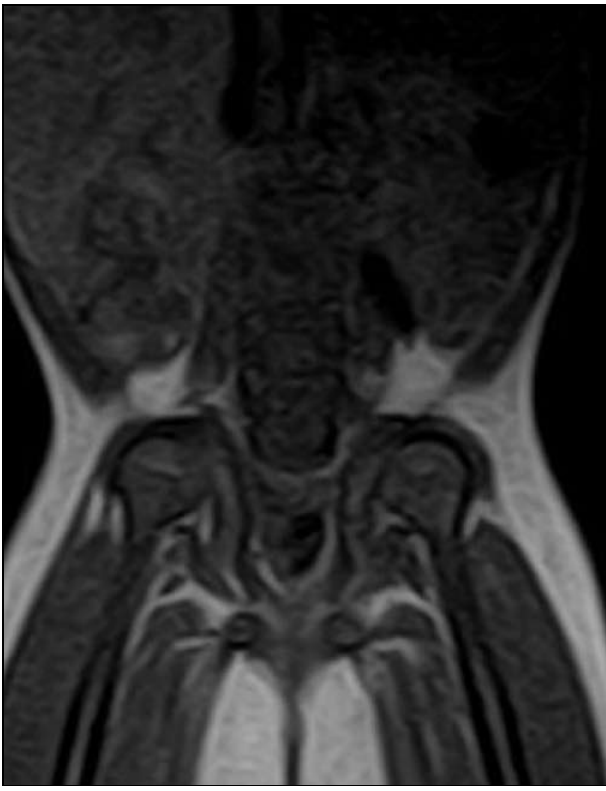
Fig.3. Coronal T1 pelvic MRI reveals iliac agenesis with the femoral heads normal and supported by surrounding muscles and fibrous